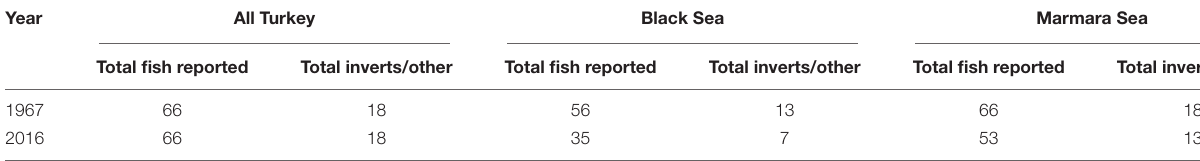
TABLE 1 | Number of reported taxa in catch statistics for 1967 and 2016 for entire Turkey, Black Sea and Marmara Sea.